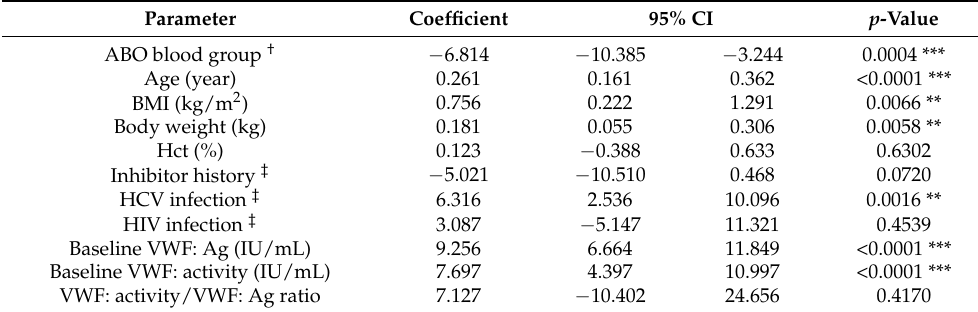
Table 5. UVLR analysis of the half lives of the entire development cohort of patients, n = 46.